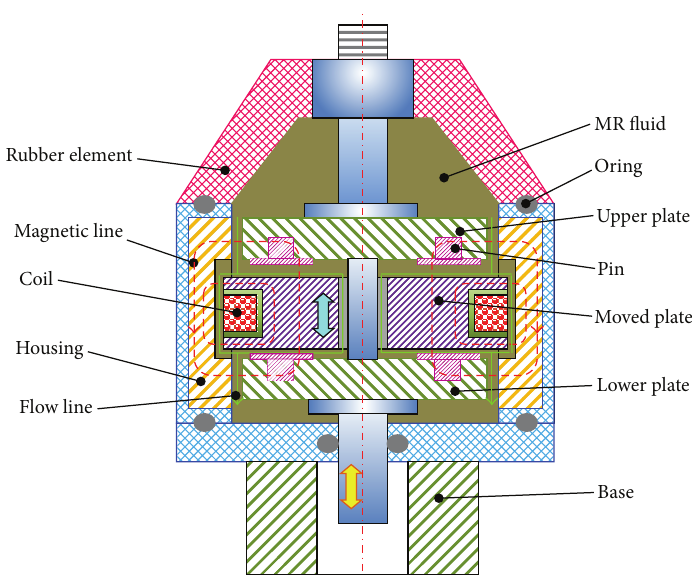
Figure 7: Configuration of high loaded MR mount with moved plate.